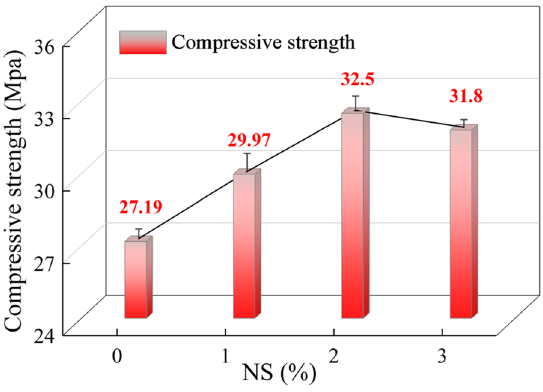
Figure 7: E ff ect of NS concentration on the compressive strength